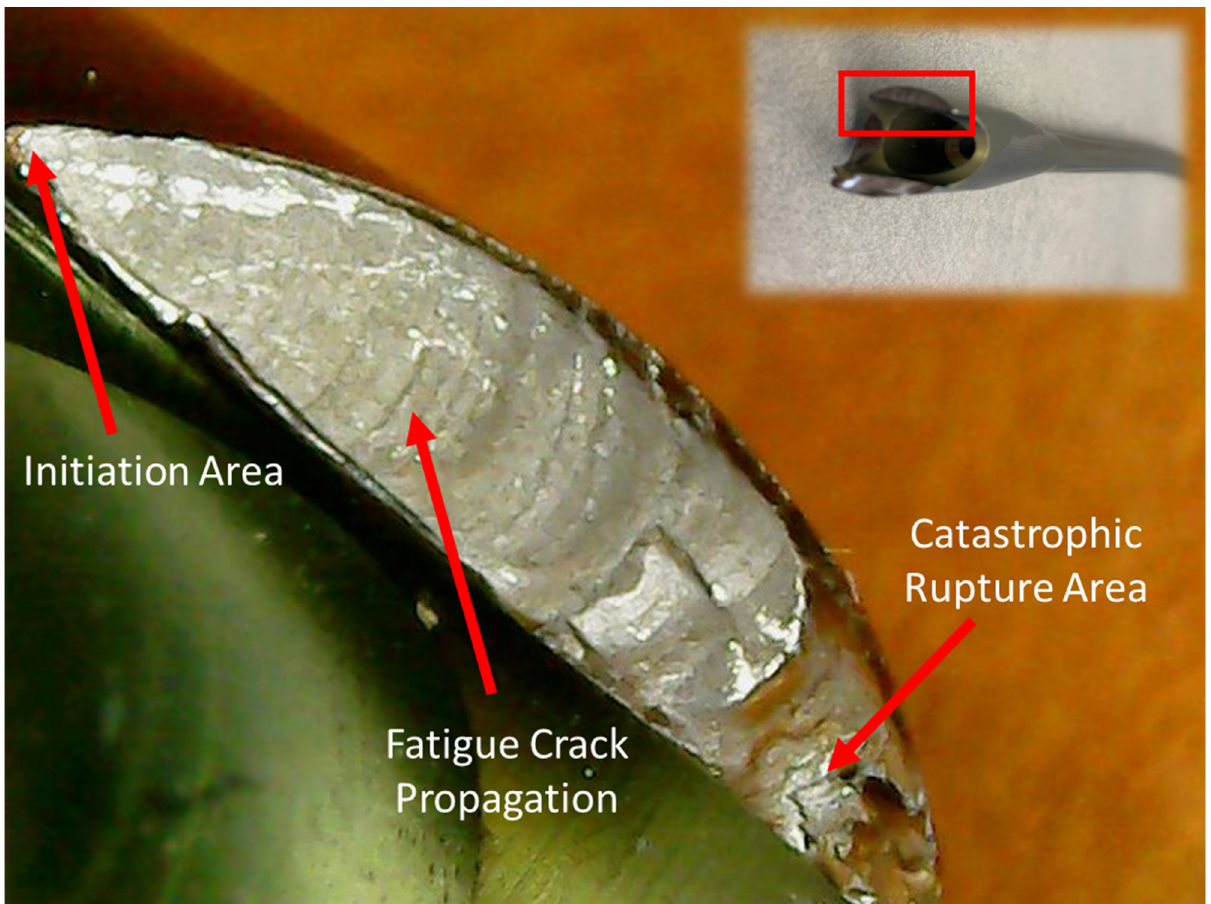
Figure 8. Closer look at the fractured surface of the femoral CM nail showing the beach marks, a good indicator of mechanical fatigue, the crack initiation area, fatigue crack propagation, and the catastrophic rupture area.